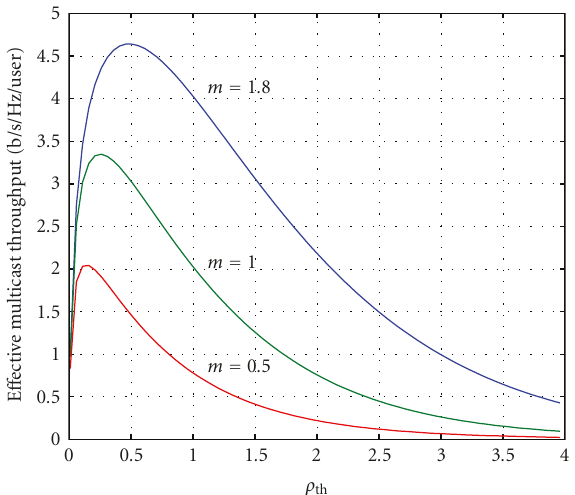
Figure 7: Optimal normalized throughput versus ρ th for ECOMP scheme in di ff erent Nakagami- m channels with average SNR of